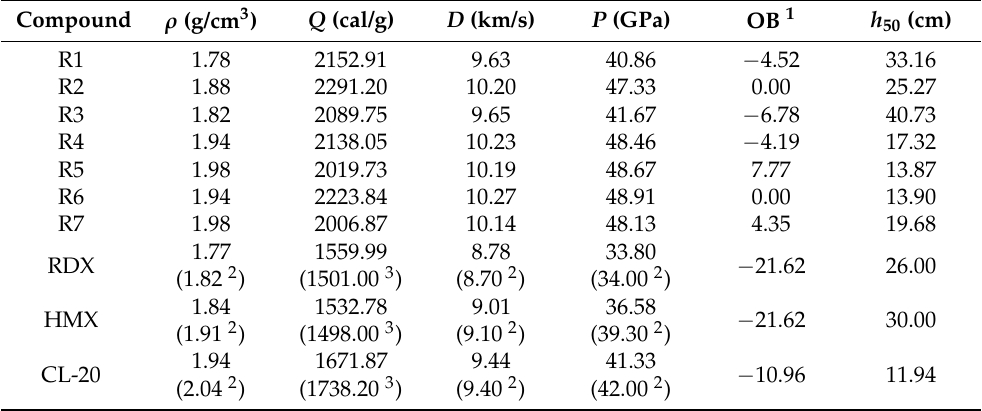
Table 1. Calculated heats of detonation ( Q ), densities ( ρ ), oxygen balances (OB), detonation velocities ( D ), detonation pressures ( P ), and impact sensitivities ( h 50 ) for the designed compounds.